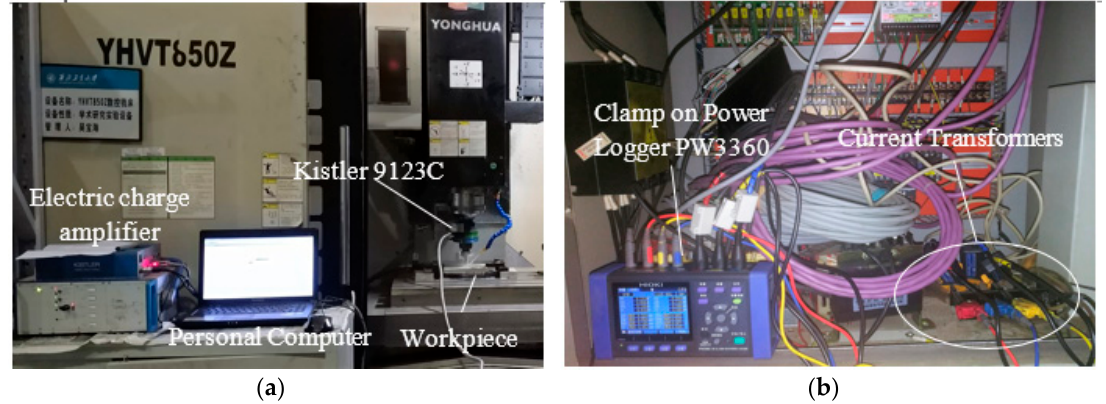
Figure 3. The experimental setup: ( a ) force and ( b ) power signal processing and collection.